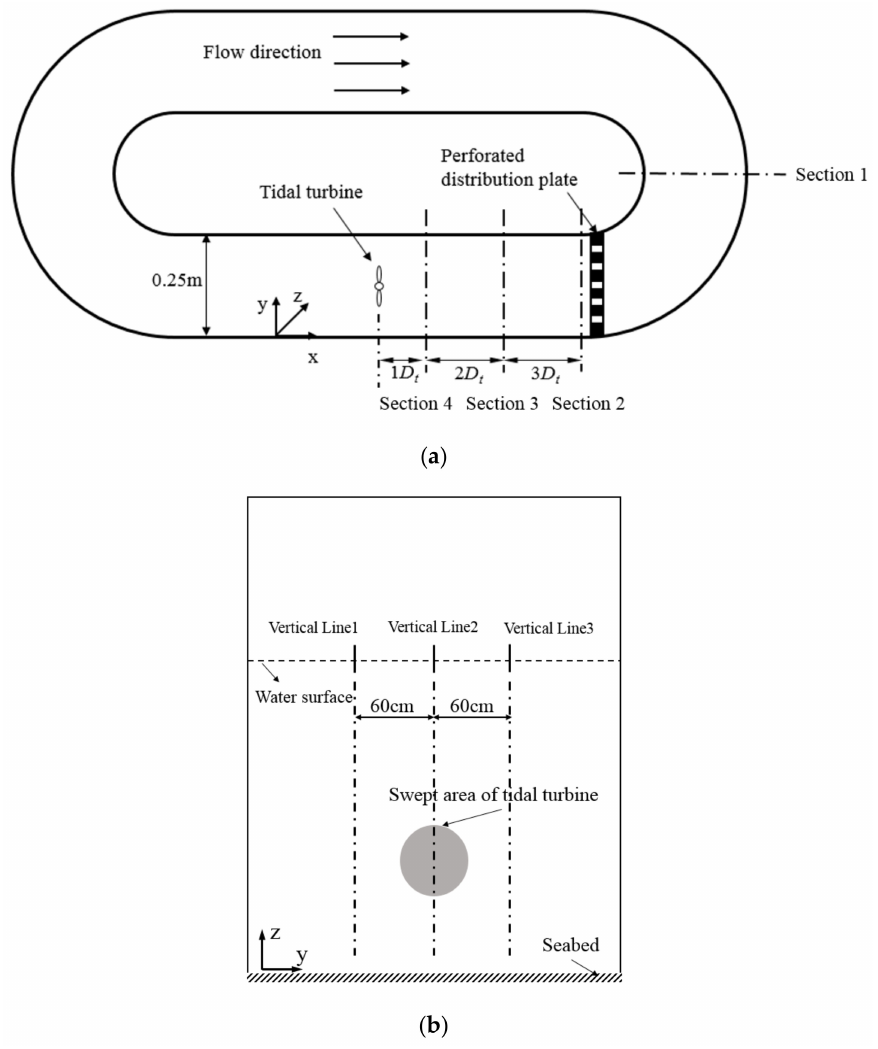
Figure 9. Position of velocity measurements: ( a ) Transverse sections. ( b ) Vertical Lines at Section